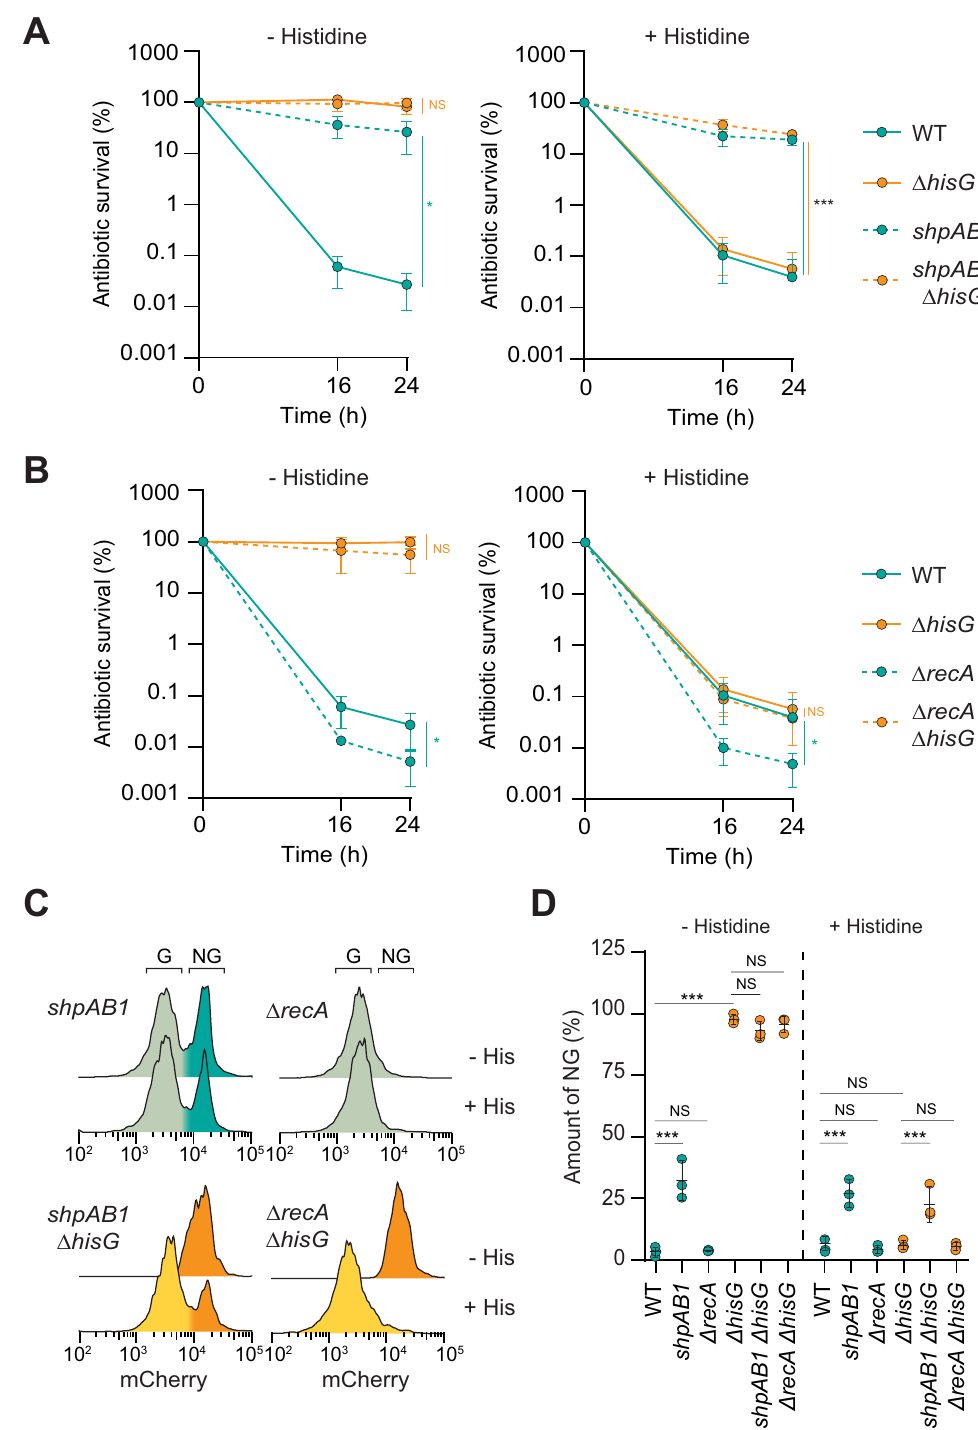
Fig 3. Tolerance can mask persister determinants in laboratory medium. ( A-B ) Survival of Salmonella 14028 exposed to cefotaxime in M9GG in the absence or presence of histidine for WT, Δ hisG , shpAB1 and shpAB1 Δ hisG or WT, Δ hisG , Δ recA and Δ recA Δ hisG . ( C-D ) Representative flow cytometry profile ( C ) and quantification of the non-grower fraction (D) of Salmonella 14028 grown in minimal medium in presence or absence of histidine for shpAB1 , Δ recA , shpAB1 Δ hisG and Δ recA Δ hisG . ( A-D ) Data represent the mean and SD of at least three biological repeats. Data from the 24 h timepoint were compared using one way ANOVA with Tukey’s multiple-comparison test, � p < 0.05, ��� p < 0.001; NS, not significant.